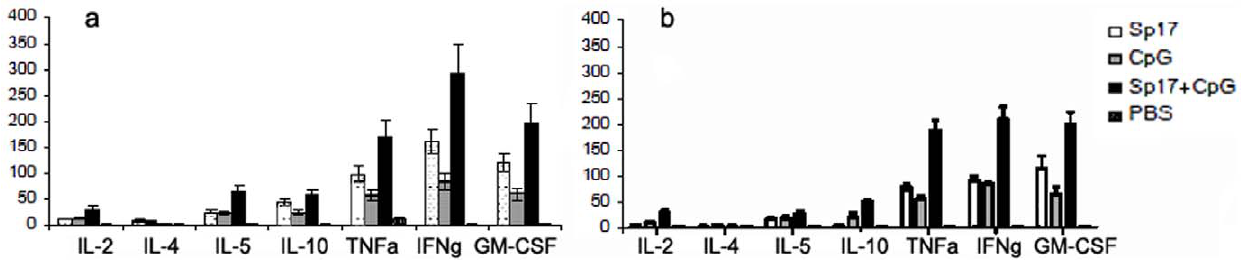
Figure 6. (a,b) Measurement of cytokines in mice treated with different vaccines. On day 300, serum was collected and analyzed by E.L.I.S.A. for the measurement of the indicated cytokine levels in prophylactically ( a ) or therapeutically ( b ) vaccinated mice. For both regimens, IFN- gamma, TNF-alpha and GM-CSF statistically significant increments were detected only in Sp17 + CpG vaccinated mice compared with controls (PBS). No significant differences were evidenced for IL-2, IL-4, IL-5 or IL-10